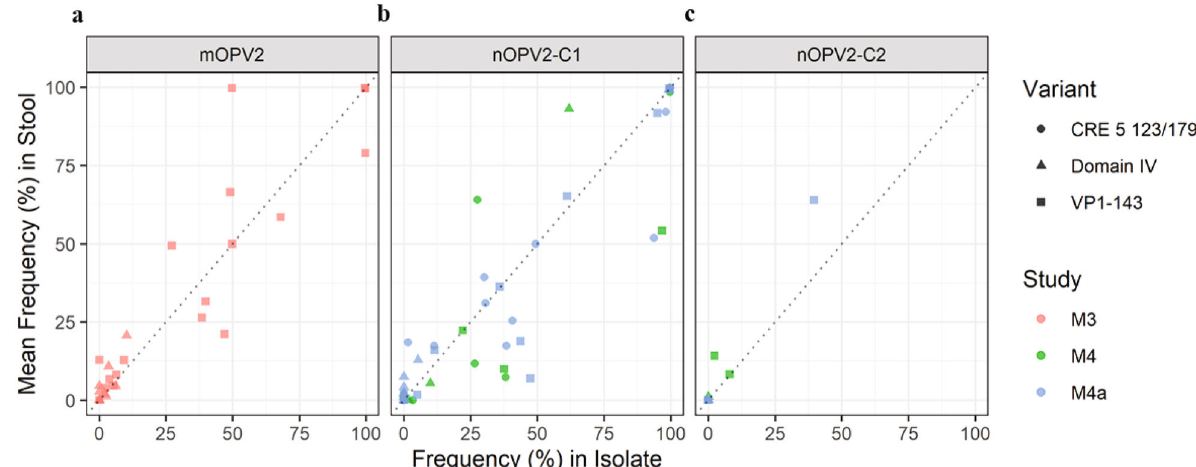
Fig. 8 Comparison of average frequency of polymorphisms measured in EES stools and corresponding cell culture isolate for polymorphisms of interest. a. mOPV2, b. nOPV2-c1 and c . nOPV2-c2 . Domain IV represents nucleotide position 398 for mOPV2/nOPV2-c2 and 459 for nOPV2-c1. VP1-143 and cre5 123/179 polymorphisms presented in aggregate for each virus. The dotted diagonal line represents the identity (1:1) line. If variant is only present in 1 stool that value is presented. If variant is not present in either, assigned 0 for plotting purposes. All variants reported have Q scores ≥ 30.